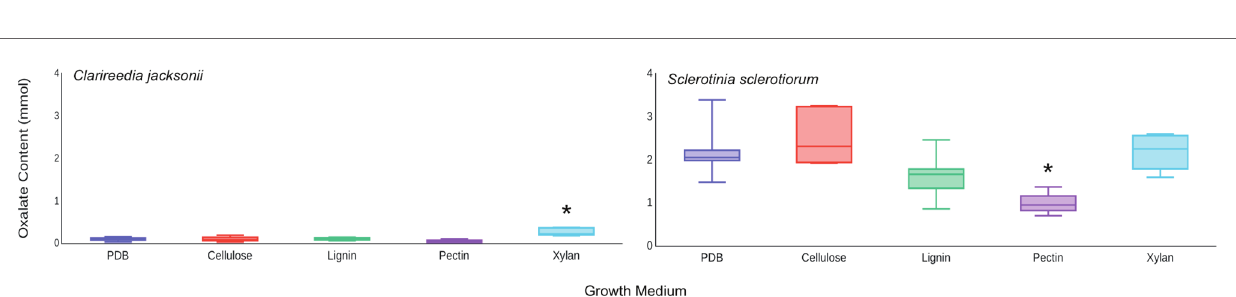
FIGURE 5 | Effect of cell wall monomers on OA production by C. jacksonii and S. sclerotiorum . OA content was determined from culture filtrates collected from cultures of C. jacksonii isolate OJN9 (left panel) and S. sclerotiorum isolate SS#21 (right panel) grown for 1-week in medium with the indicated cell wall component monomer amendments. Results from the two fungi were separated due to large differences in OA production. A Dunnett’s test was used to compare OA production in cell wall component-amended media against the unamended PDB control for each fungus. Boxes with asterisks above them were significantly different from the PDB control at a significance level of α = 0.05. This experiment was repeated three times with three replicates per treatment in each repetition. Median and first-third quartile intervals are shown.